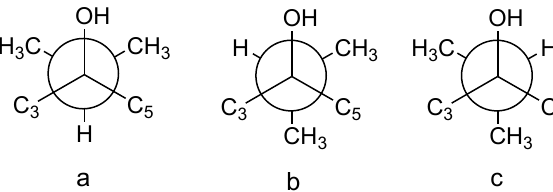
Figure 2. Conformation of C(4) substituent of 10-12